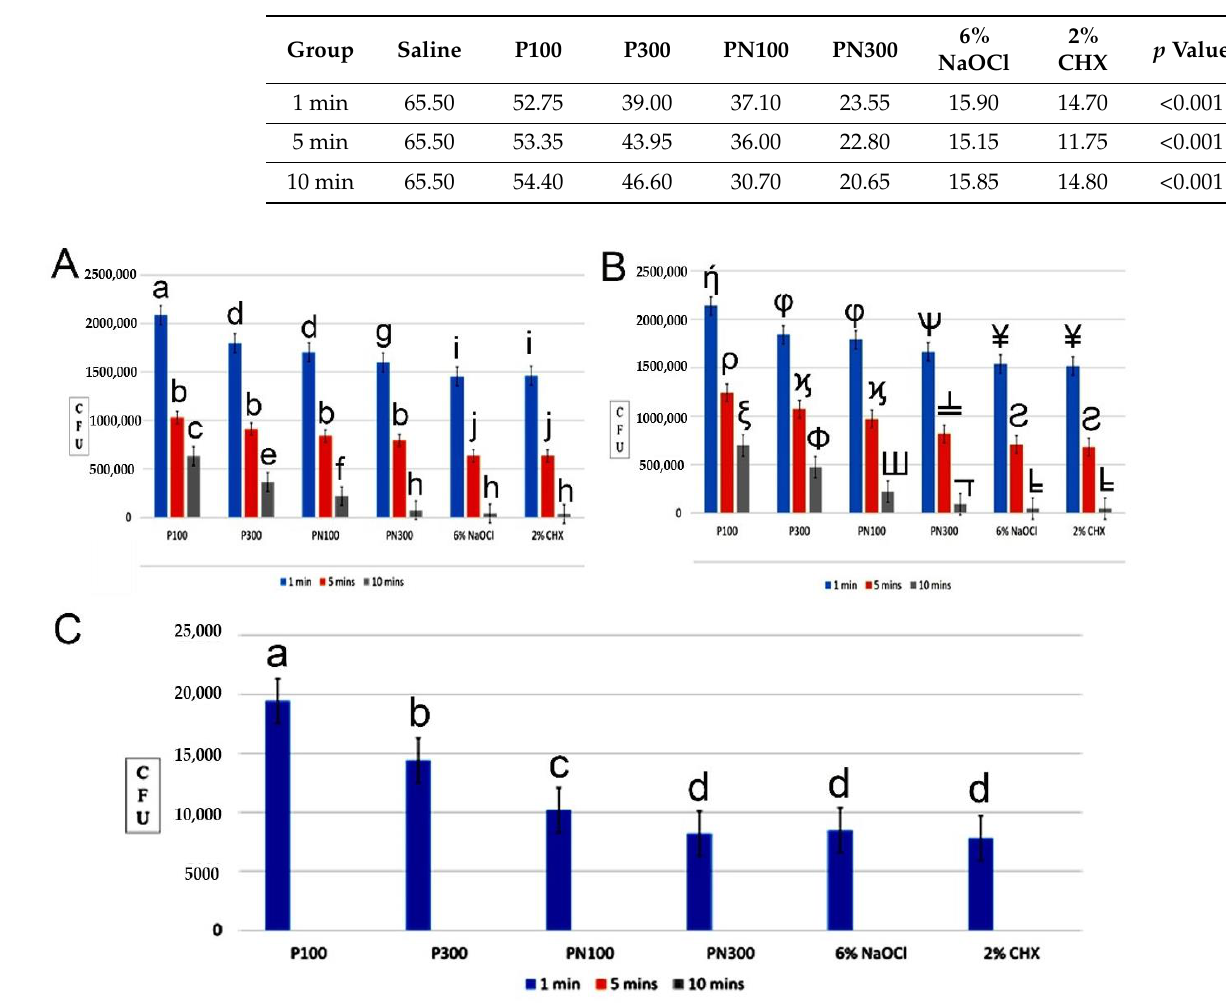
Figure 2. ( A ) Mean reduction in CFU at 1, 5, and 10 min at 200 µ m dentinal tubule depth. ( B ) Mean reduction in CFU at 1, 5, and 10 min at 400 µ m dentinal tubule depth. ( C ) Comparison of CFUs count between propolis nanoparticles (PNs) and other endodontic irrigants at 1, 5, and 10 min against Enterococcus faecalis isolates from patients with failed root canal treatment. Groups identified by different alphabets and symbols were significantly different at p < 0.05 in columns, respectively. The alphabets and symbols are in quasi-alphabetical order and are ordered according to the statistical difference between